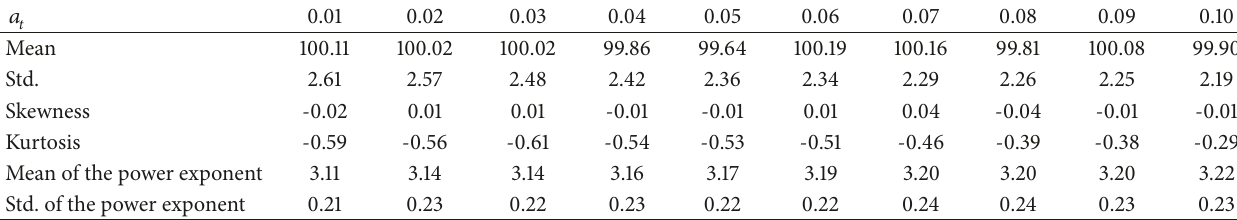
Table 2: Sensitivity analysis of the parameter of exponential distribution 𝑎 𝑡 .